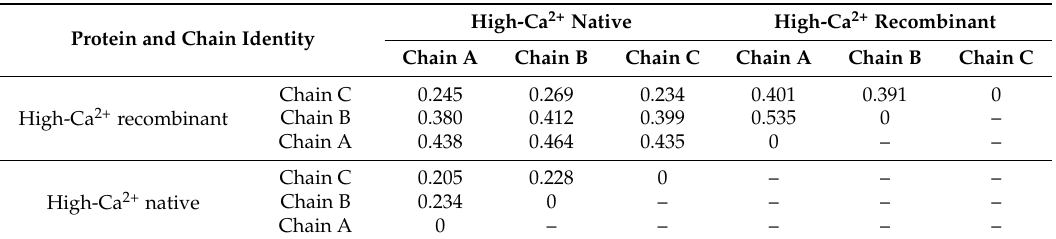
Table 1. Root-mean-squared deviation (in Å) for C α least-squares superposition of Pro7 through Pro334 between the high-Ca 2+ structures of native and recombinant bovine Casq1. Protein and Chain Identity